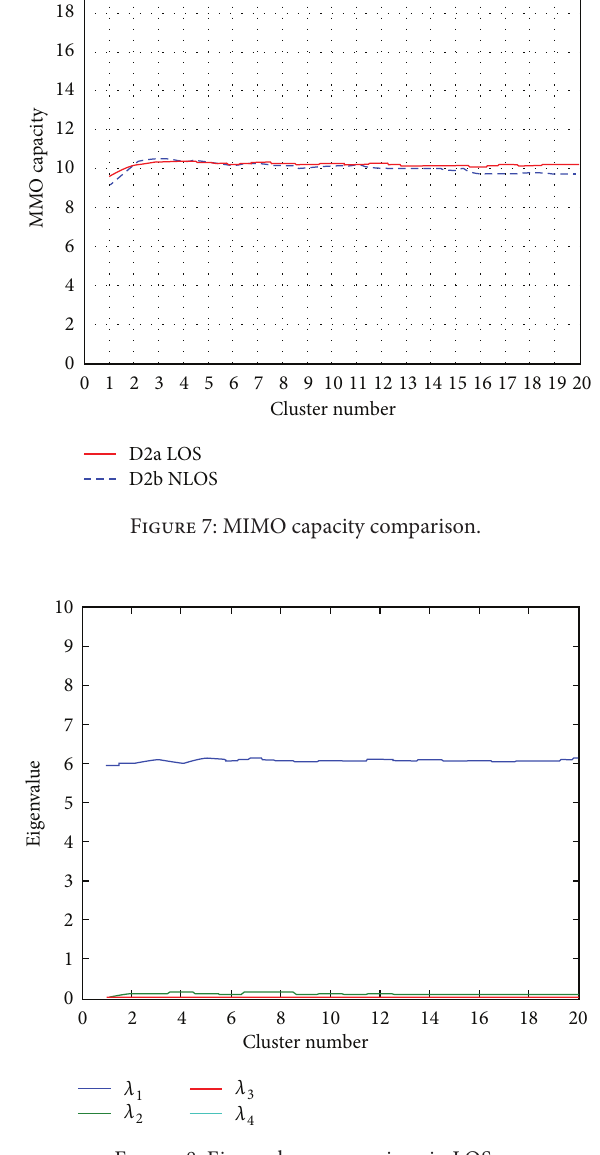
F 8: Eigenvalues comparison in LOS.